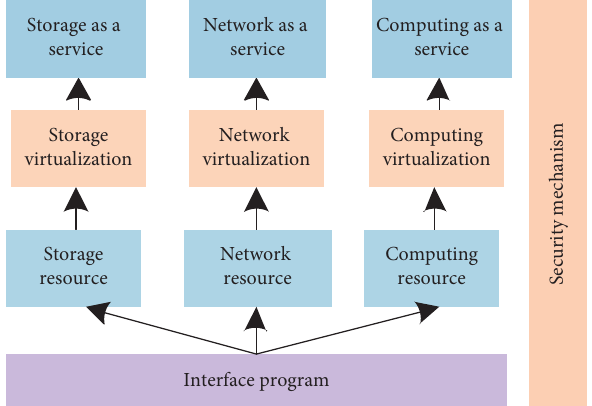
Figure 2: Cloud audit platform infrastructure layer.